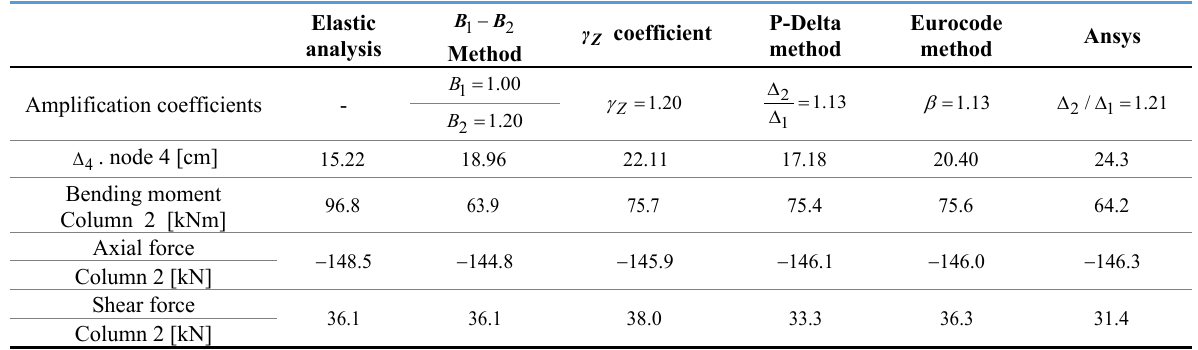
Table 1 – Summary of results. Source: Authors (2020).